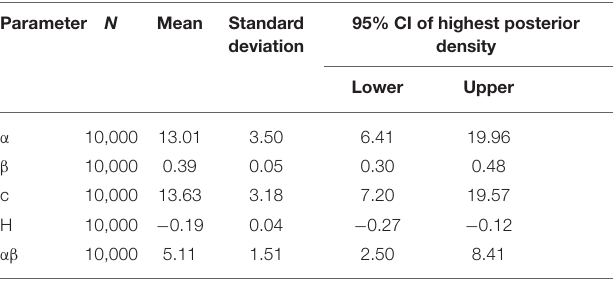
TABLE 4 | Parameter summary of Bayesian mediation analysis with SSP as mediator. Parameter